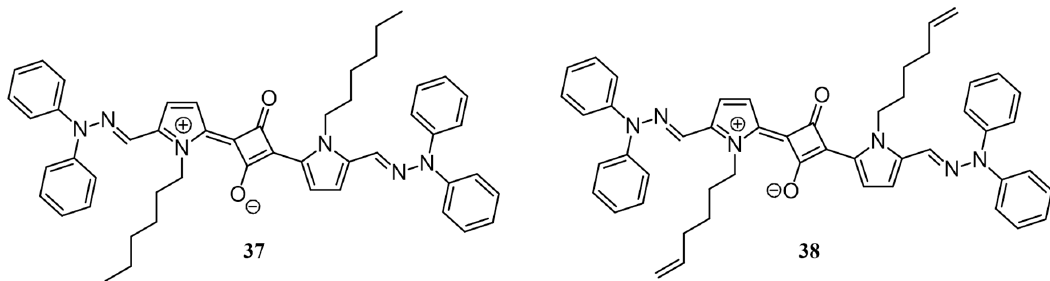
Figure 15. Chemical structures of 37 and 38 synthesized by Facchetti et al. [64].